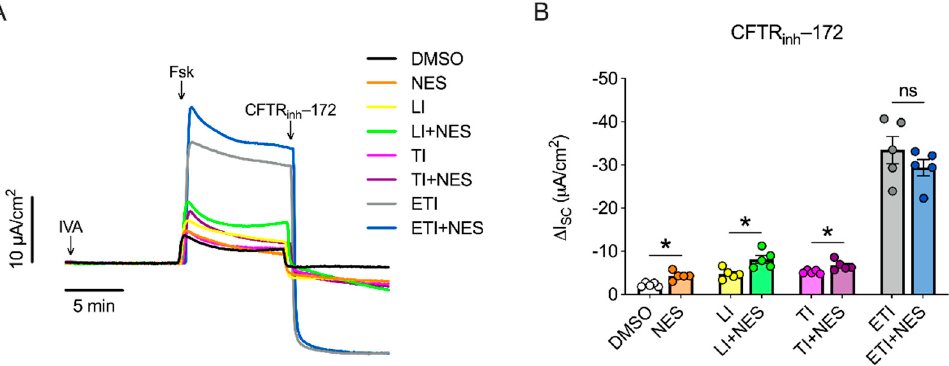
Figure 1. Effects of nesolicaftor (NES) on modulator-corrected F508del CFTR function in 16HBEge cells in vitro. ( A ) Confluent monolayers of F508del CFTR 16HBEge cells were treated with